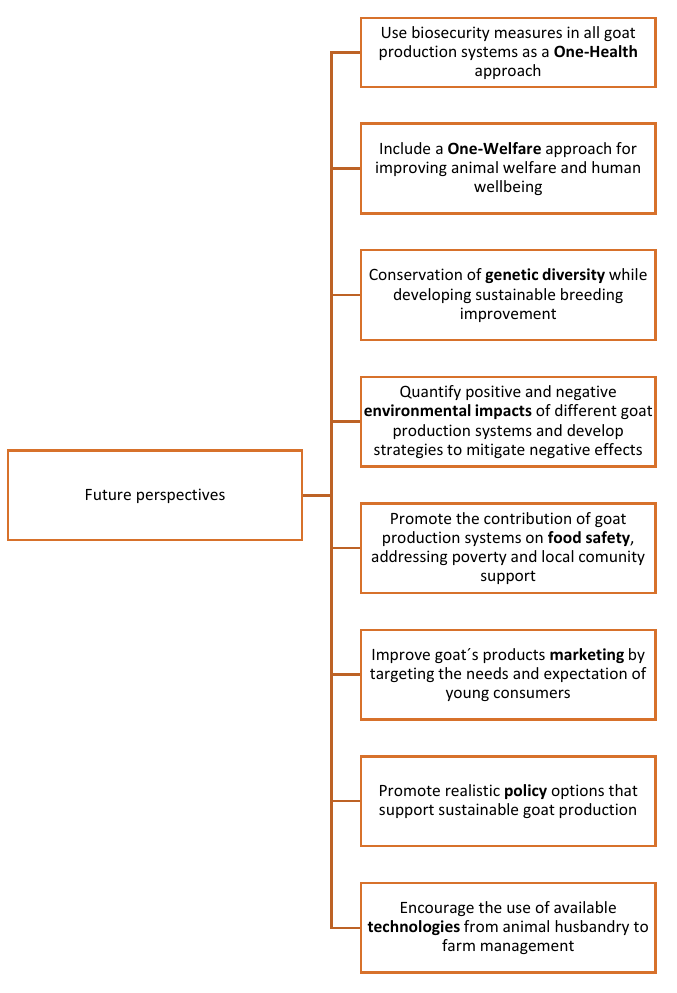
Figure 6. Future perspectives for Mexican goat production development.